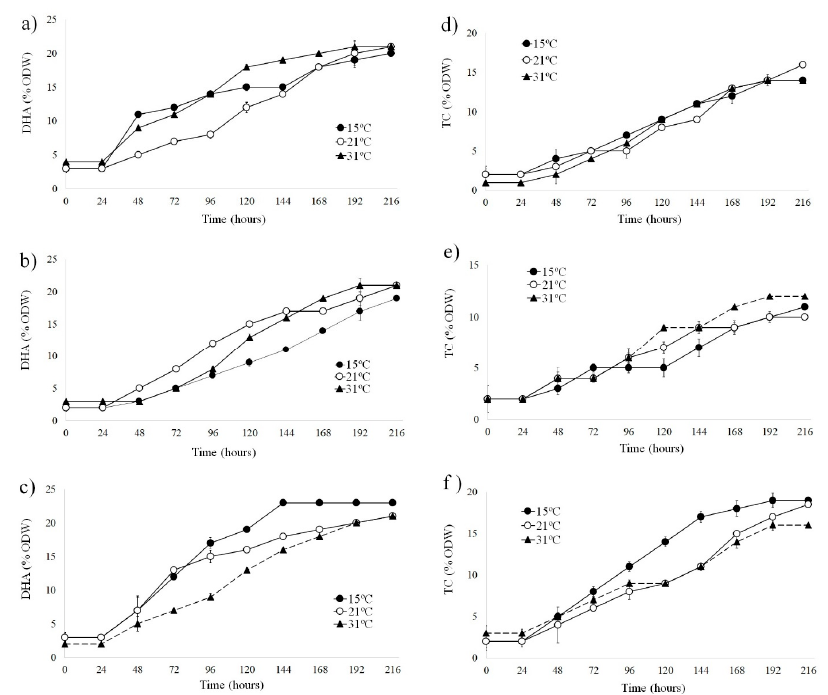
Figure 2. Average productions ± SD docosahexaenoic acid (DHA) and total carotenoids (TC) of the NCYC4007 and NCYC1146 strains. ( a – c ). Culture from the NCYC4007 strain in bioprocesses with SM, AGM and RGM media, respectively. ( d – f ). Culture from the NCYC1146 strain in bioprocesses with SM, AGM and RGM media, respectively. The production of these substances is shown in percentages, in respect to the biomass in oven-dried weight (ODW). Table 2. Fatty acids profile from the NCYC 4007 strain cultivated in three different culture media at 15 ○ C: Sabouraud medium (SM), media formulated with analytic grade glycerol (AGM) and raw glycerol (RGM). The results are shown as the percentage of total fatty acid (TFA). In addition, the amount of fatty acids (FA) and DHA are showed in mg g − 1 freeze-dried weight (FDW) biomass. Carbon Source